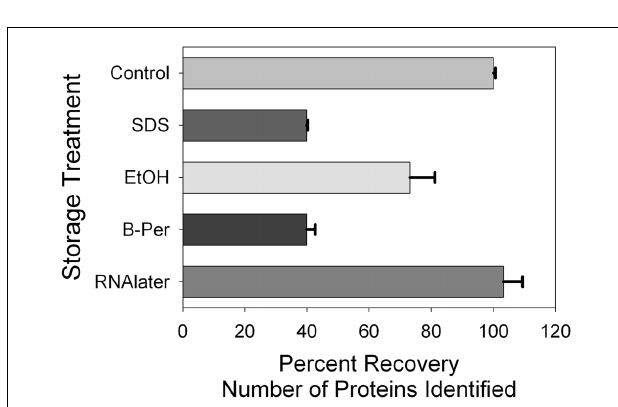
FIGURE 3 | Comparison of number of protein identifications acquired from the control and four preservation techniques. Each sample was analyzed twice by LC–MS and the values reflect the average and SD, normalized to the control treatment (504 ± 4 protein identifications in each technical replicate of the control sample, the control =